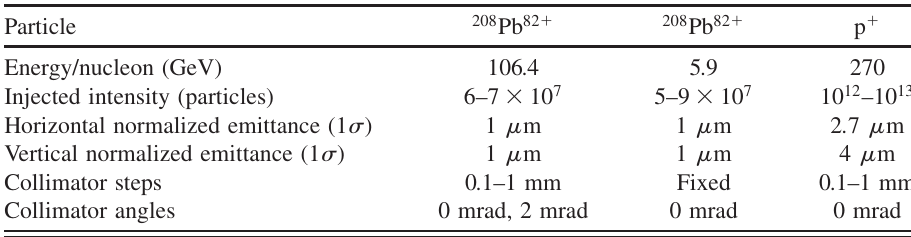
lating beam with a 5 : 9 GeV = nucleon beam intercepted by the collimator di- rectly after injection. The corresponding momentum dur- ing the magnetic cycle of the SPS in both cases is shown in Fig. 8. In the case of the low energy beam injected on the collimator, the data were collected at the injection plateau TABLE II. The parameters of the beams in the SPS used for the collimation